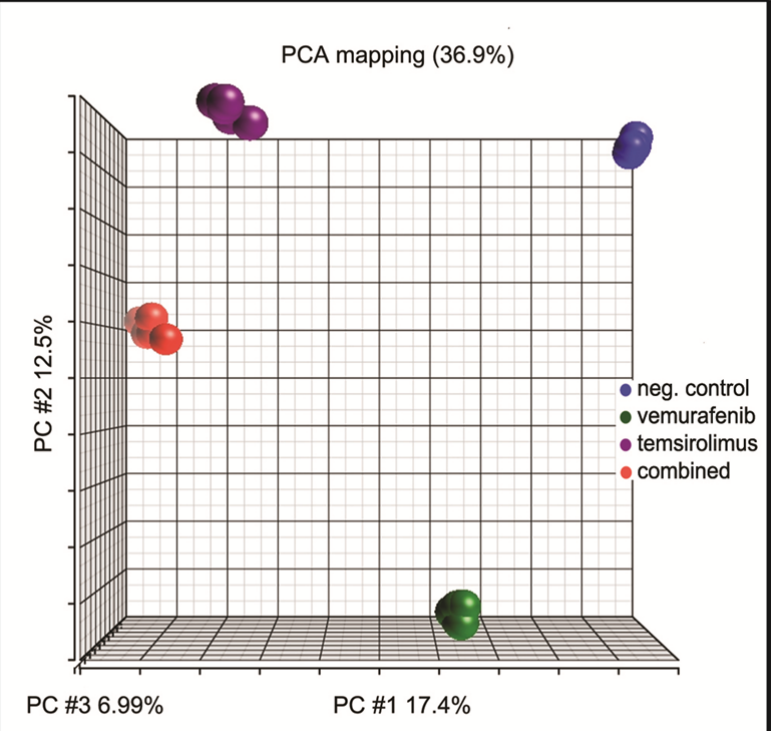
Figure 5. Principal component analysis (PCA) of H1_DL2 cells after drug treatment with vemurafenib and temsirolimus. PCA analysis of all 20 samples resulted in four distinct clusters for each of the respective treatments: Untreated samples (blue), vemurafenib-treated cells (15 µM; green), temsirolimus-treated cells (25 µM; purple) and the combination treatment (5 µM each; red) ( n = 5 for all